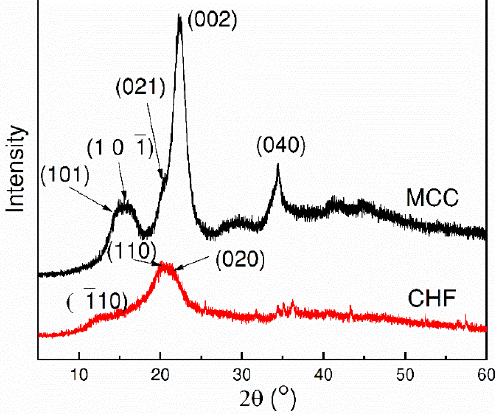
Figure 7. The XRD patterns of MCC and CHF.